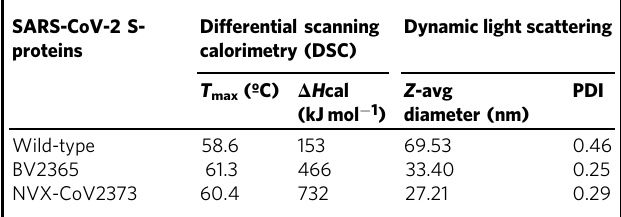
speci fi cally bound hACE2 but failed to bind the hDPP4 receptor used by MERS-CoV (IC 50 > 5000 ng mL − 1 ). WT and BV2365 bound to hACE2 with similar af fi nity (IC 50 = 36 – 38 ng mL − 1 ), while NVX-CoV2373 attained 50% saturation of hACE2 binding at a twofold lower concentration (IC 50 = 18 ng mL − 1 ) (Fig. 2d – f).